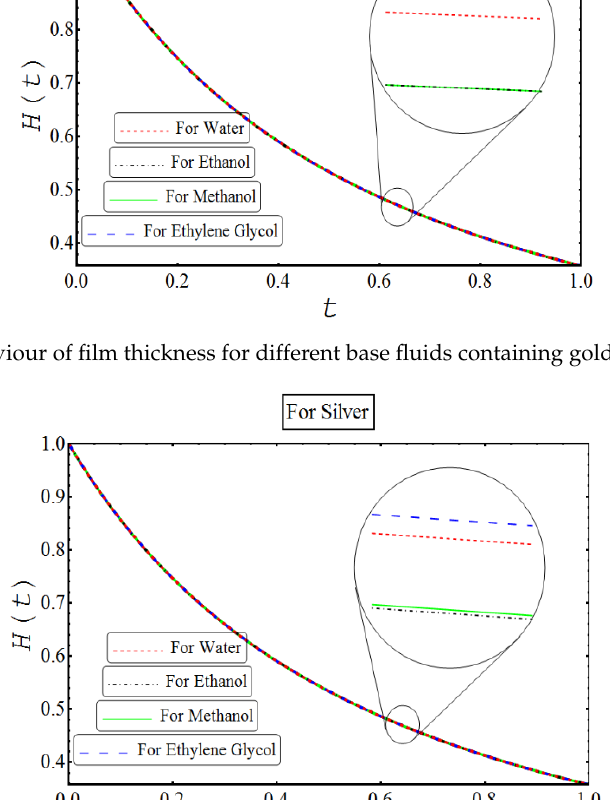
Figure 4. Behaviour of film thickness for thermocapillary parameter for gold particles. Figure 5. Behaviour of film thickness for thermocapillary for silver particles parameter.